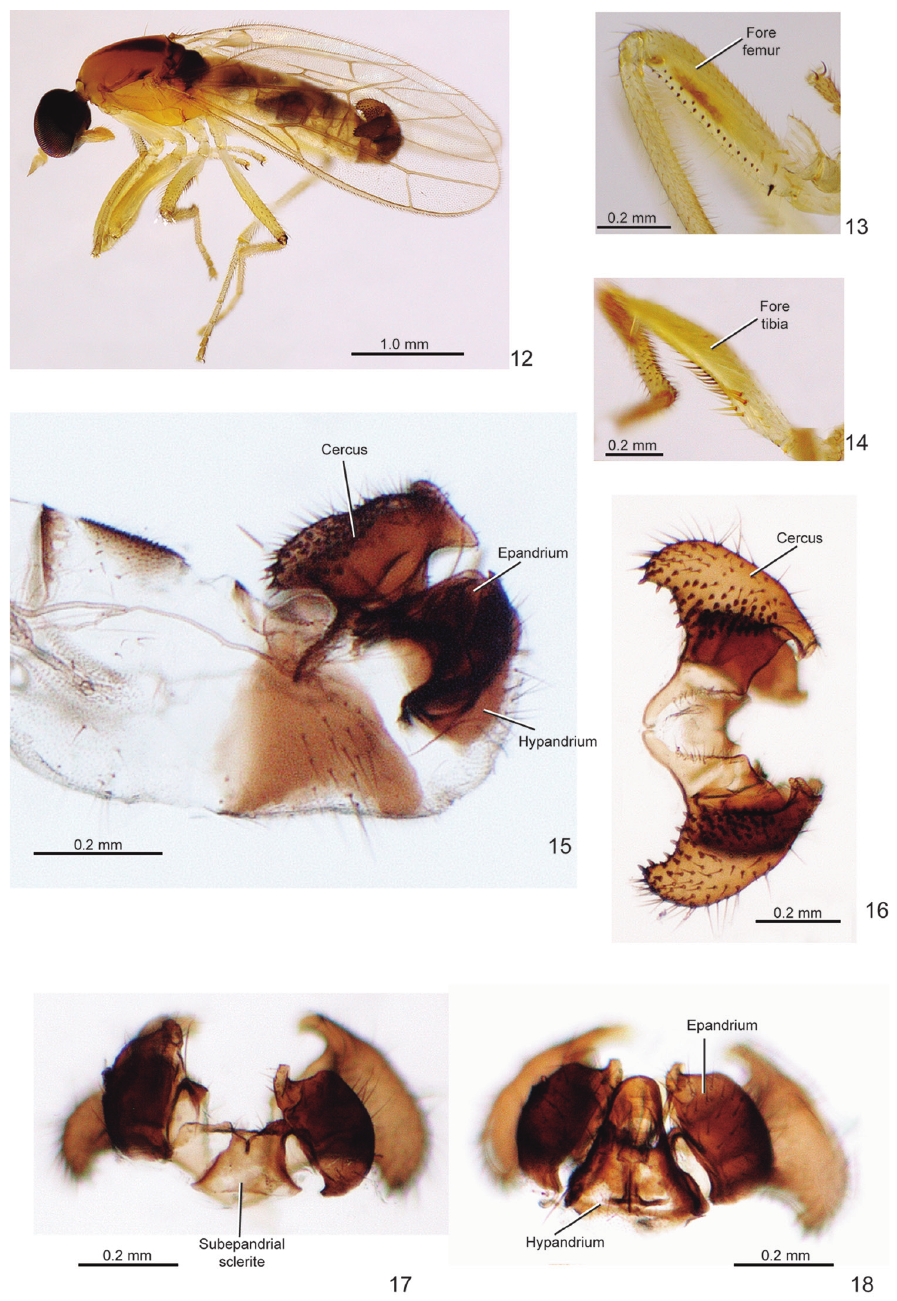
Figures 12–18. Metachela spinulosa sp. n., holotype male. 12 Habitus, dorsolateral view 13 Right fore femur, anteroventral view 14 Right fore tibia, anteroventral view 15 Abdomen from segments 7–11, lateral view 16 Cercus, dorsal view 17 Subepandrial sclerite and epandrium, dorsal view 18 Hypandrium and epandrium, ventral